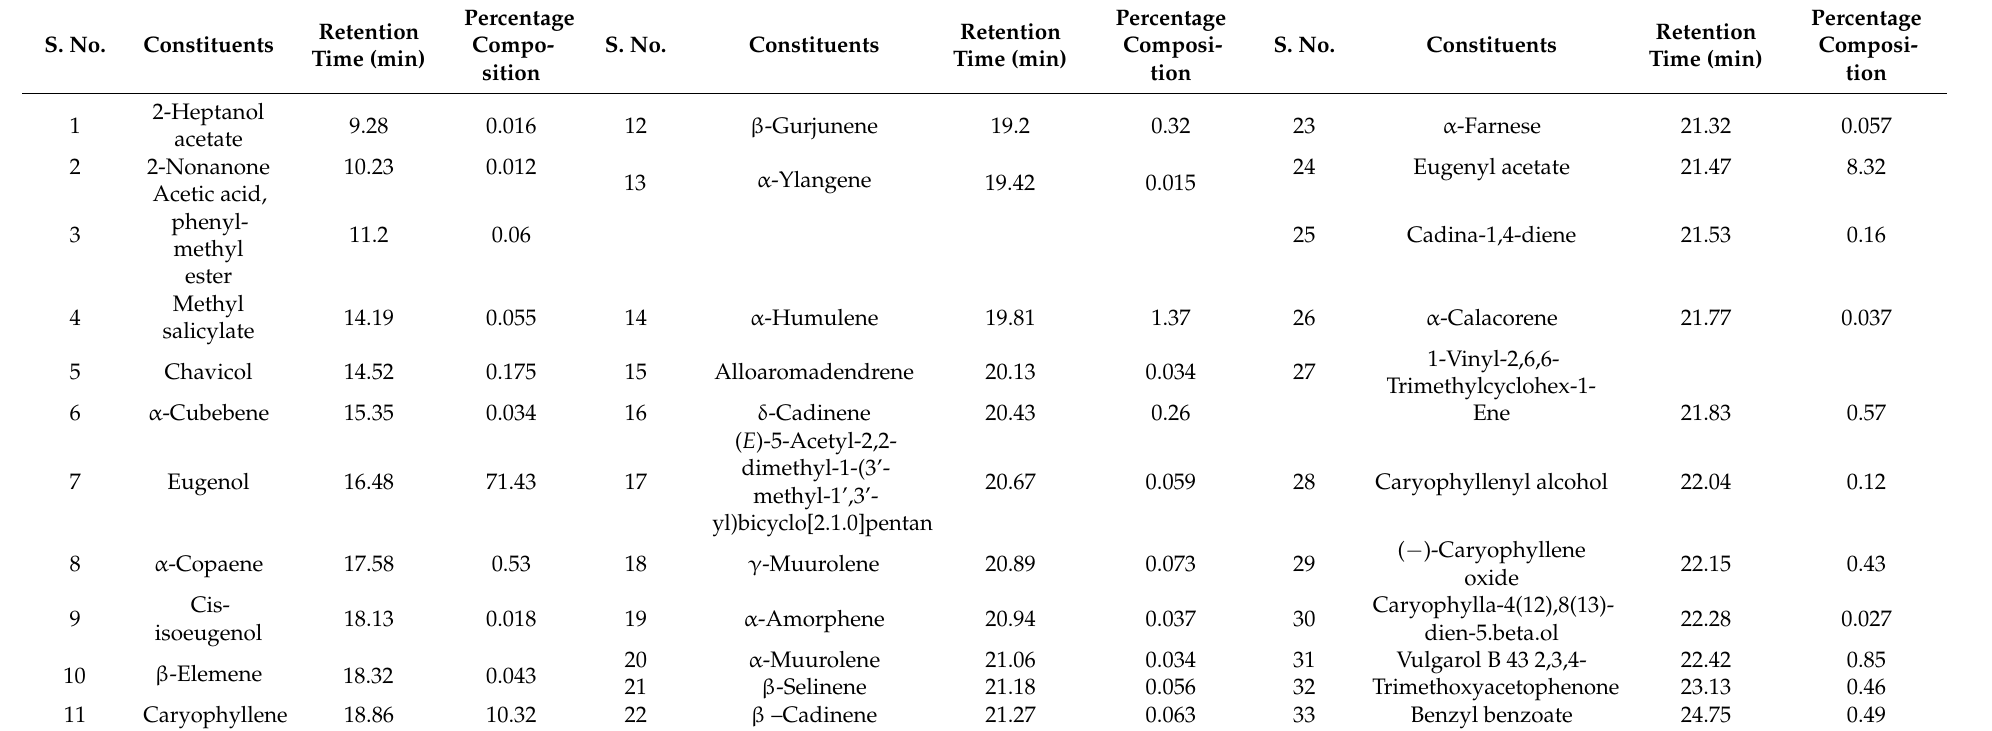
Table 1. Percentage composition of various constituents identified in CEO by